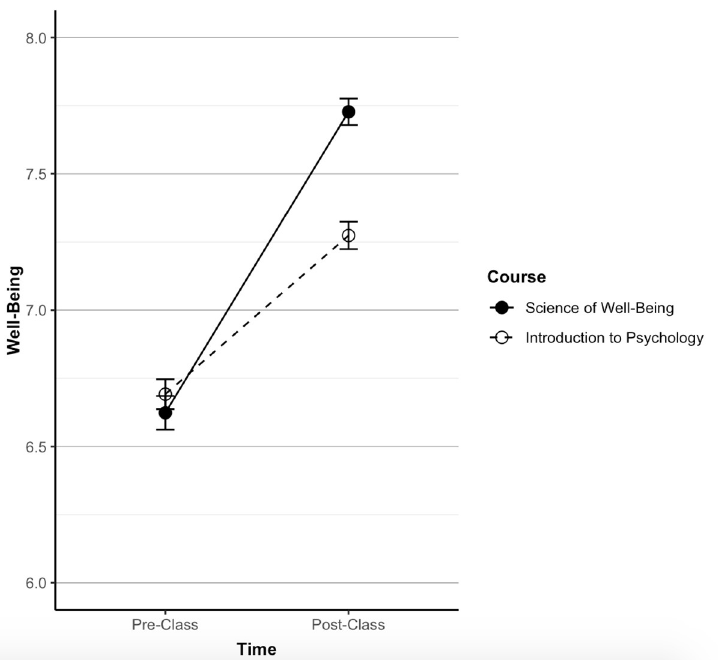
Fig 1. Comparison of well-being across courses in sample one. In the first time-span, the SoWB course ( N = 581) and the control course ( N = 677) did not differ at baseline but were different at follow-up ( SoWB , M = 7.73, SD = 1.17; Control, M = 7.27, SD = 1.30, r = .18, d = .37, p <